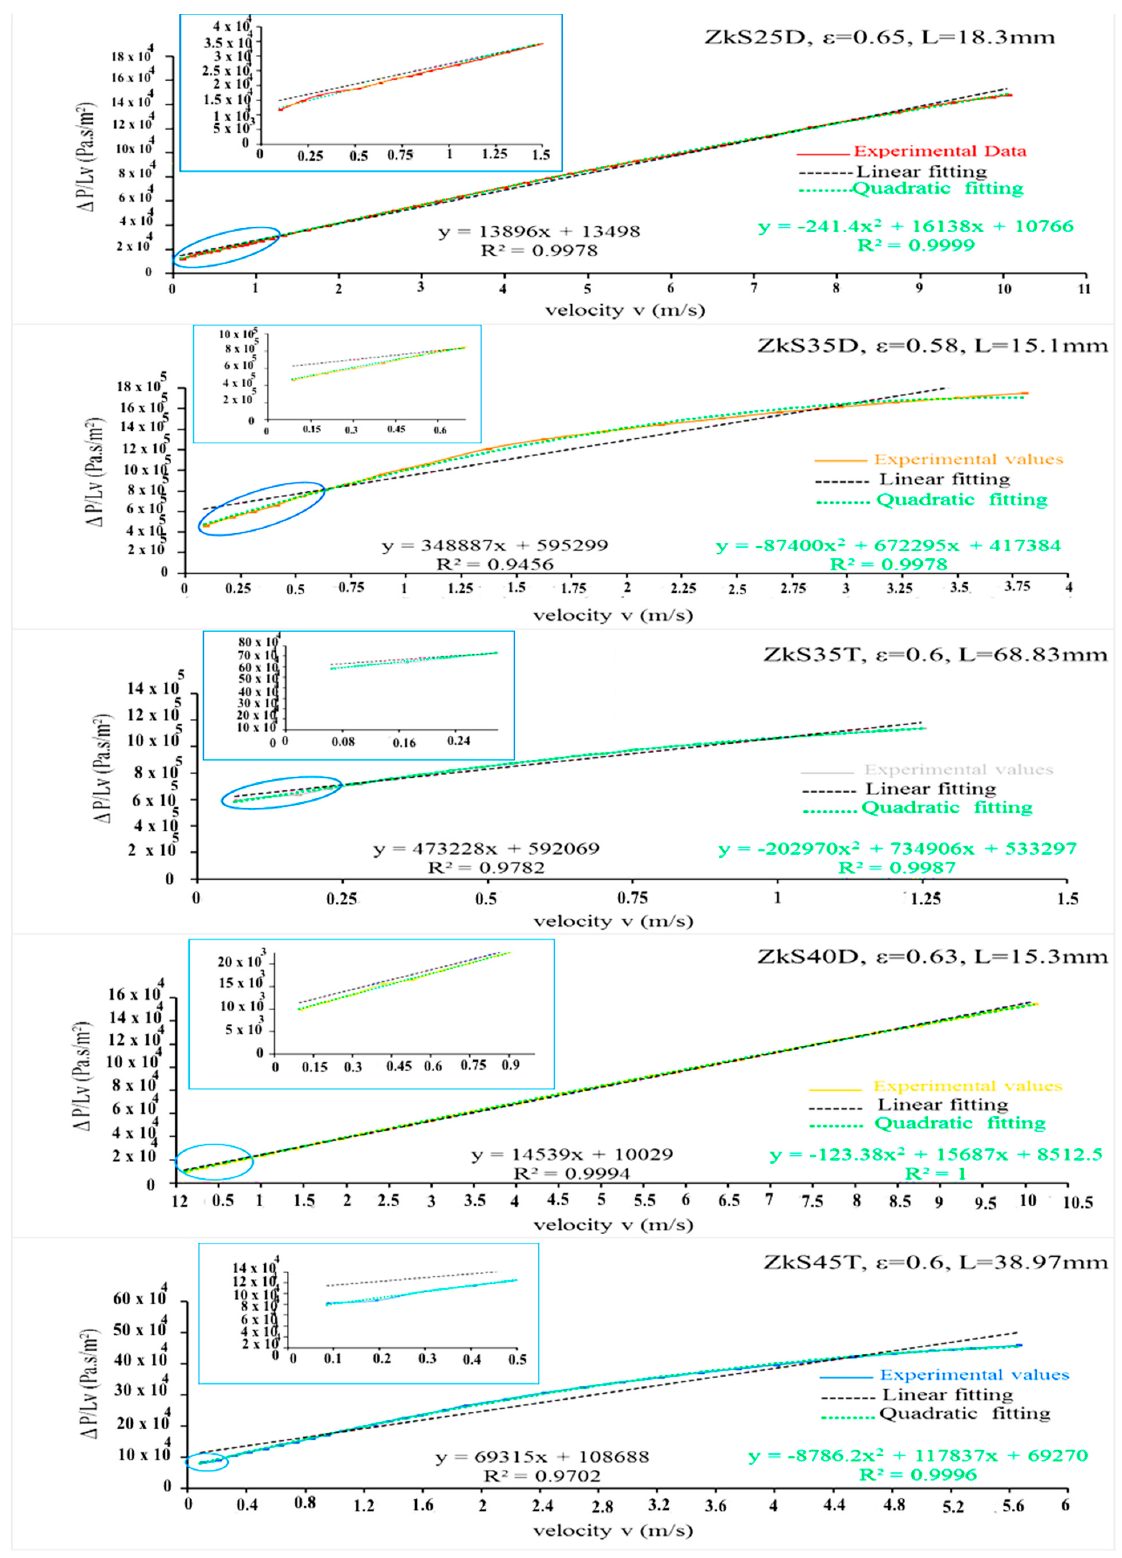
Figure 6. Linear and quadratic fitting of experimental results of reduced pressure drop versus superficial air velocity for each sample.